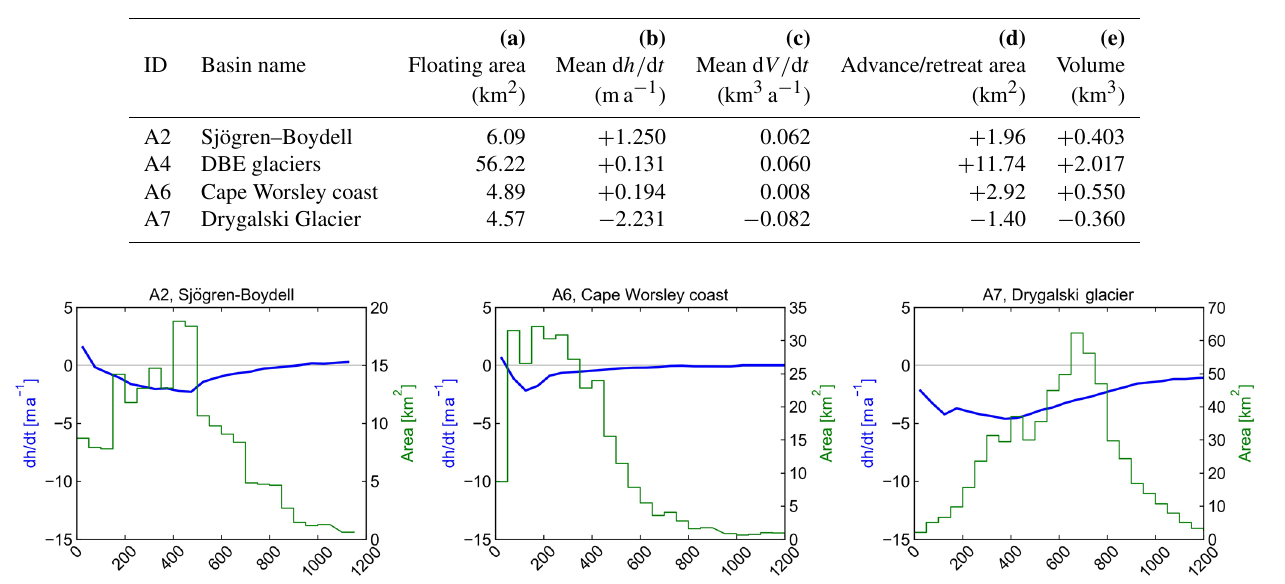
Table 2. (a) Area extent of floating ice in 2016; (b) and (c) show rate of surface elevation change and volume change 2013 to 2016 of floating ice; ( a–c ) exclude the areas of frontal advance; (d) and (e) show the extent and volume of frontal advance ( + ) or retreat ( − ) areas.